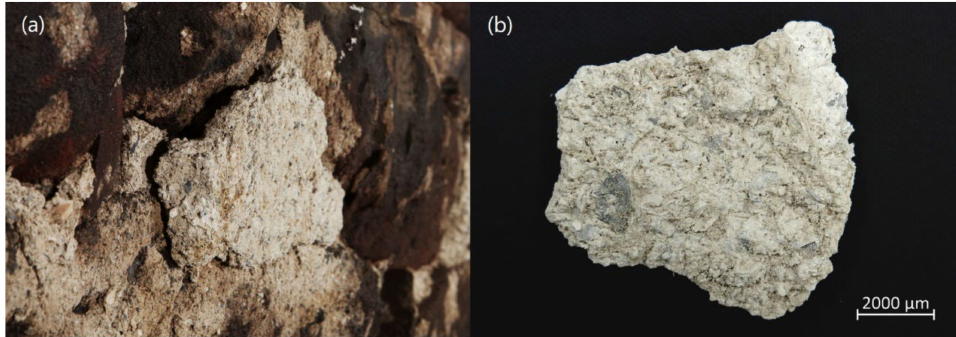
Figure 3. Plaster sample by control group: ( a ) Sampling points. ( b ) Plaster sample details.